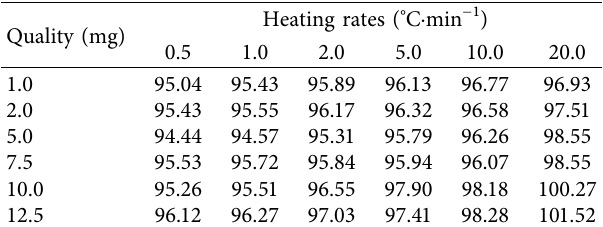
Table 1: The initial melting point at different mass points at different heating